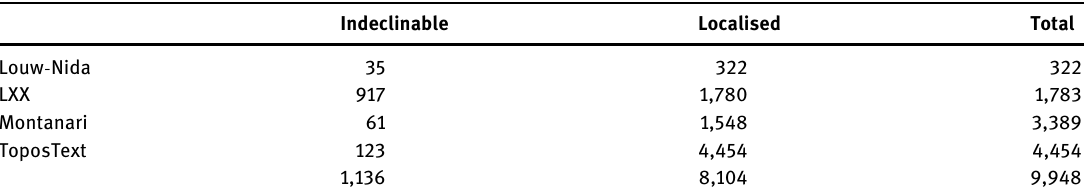
Table 1: Statistics about the toponym data sets Indeclinable Localised